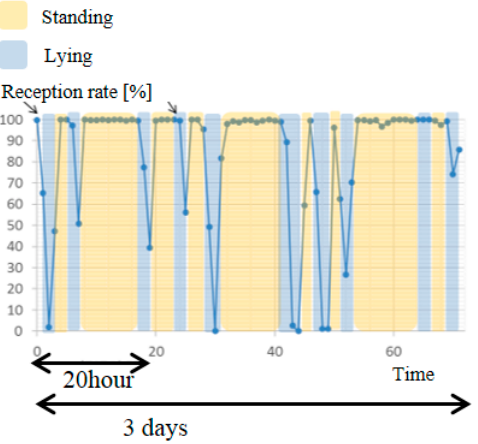
Figure 8. Reception rate per hour for 3 days of wireless sensor nodes.